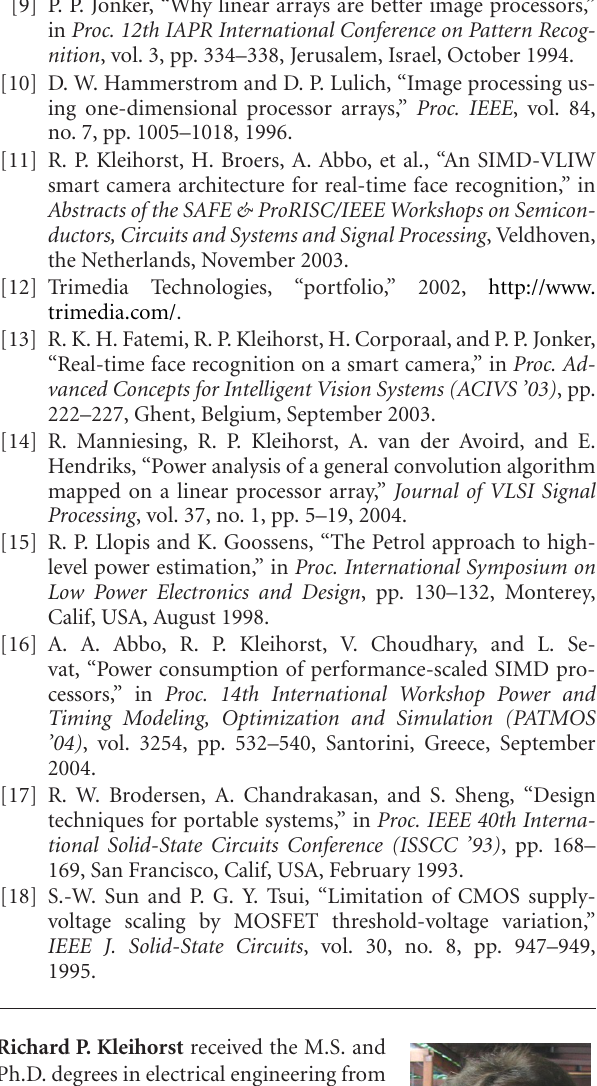
certain number of processors is used. The SIMD area in- crease is linear in the number of processors with an o ff